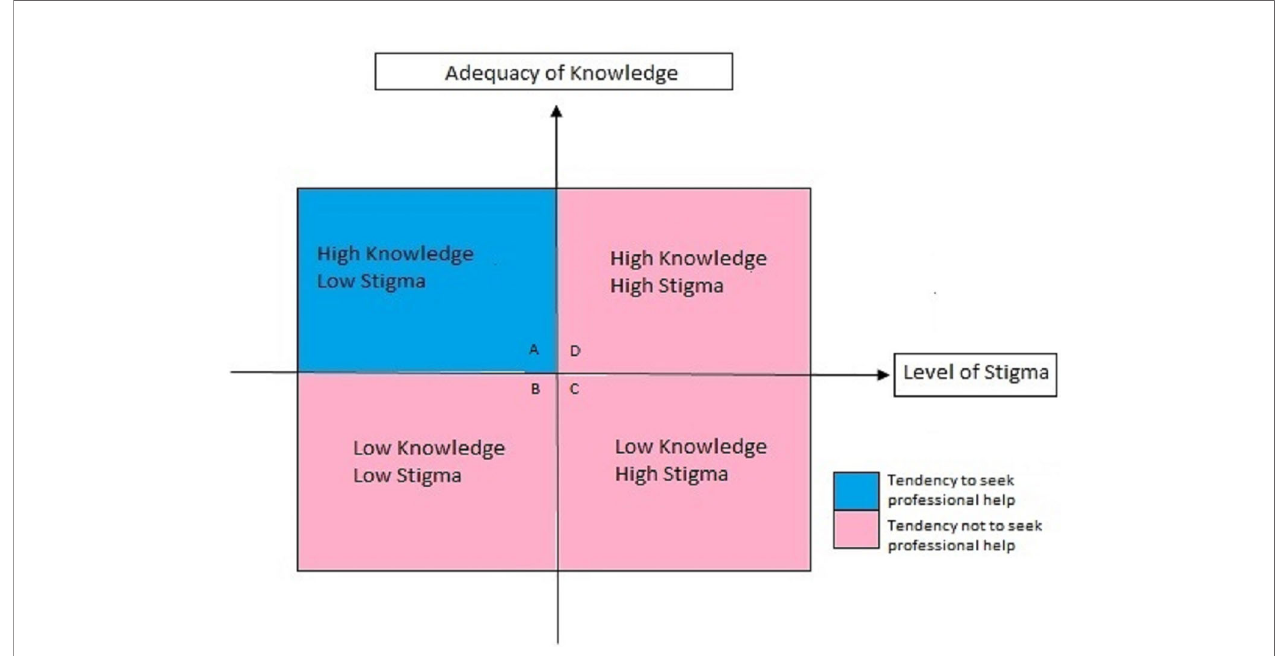
FIGURE 1 | Dynamic relationship of knowledge and